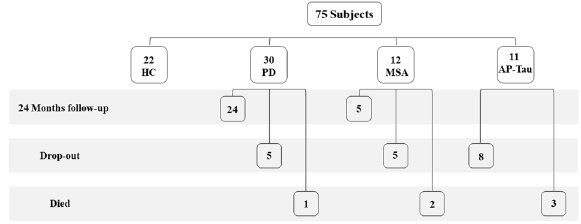
Fig. 1 Flowchart of the study population. Study groups are shown longitudinally in time.